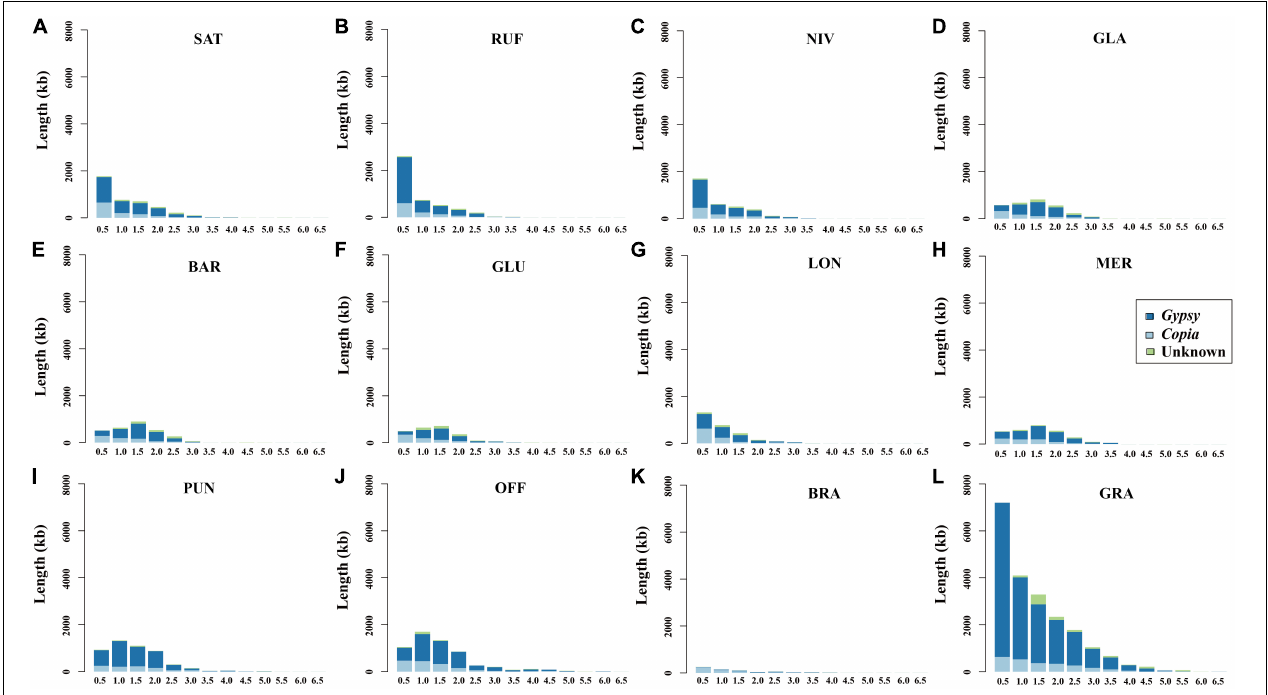
FIGURE 5 | Length of intact LTR-RTs inserted in the twelve examined Oryza genomes at different time periods. The values on the abscissa represent the insertion time span of the intact LTR-RTs, and the adjacent values take 0.5 as an interval value. For example, 1 represents the time period from 0.5 to 1 million years ago (MYA). (A–L) Represents O. sativa , O. nivara , O. rufipogon , O. barthii , O. glaberrima , O. glumaepatula , O. longistaminata , O. meridionalis , O. punctata , O. officinalis , O. brachyantha, and O. granulata,